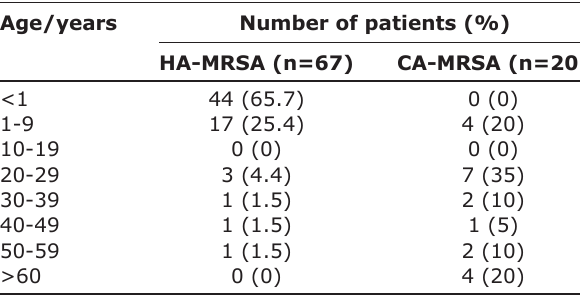
Table-1: Age distribution of MRSA